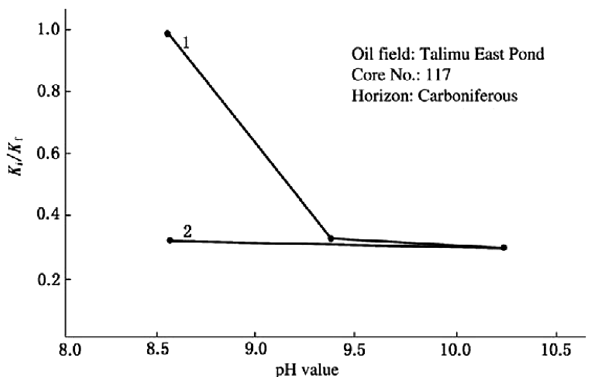
Fig. 1 Sensitivity evaluation of Talimu East oil field core sample to the alkalinity (Renpu 2011)